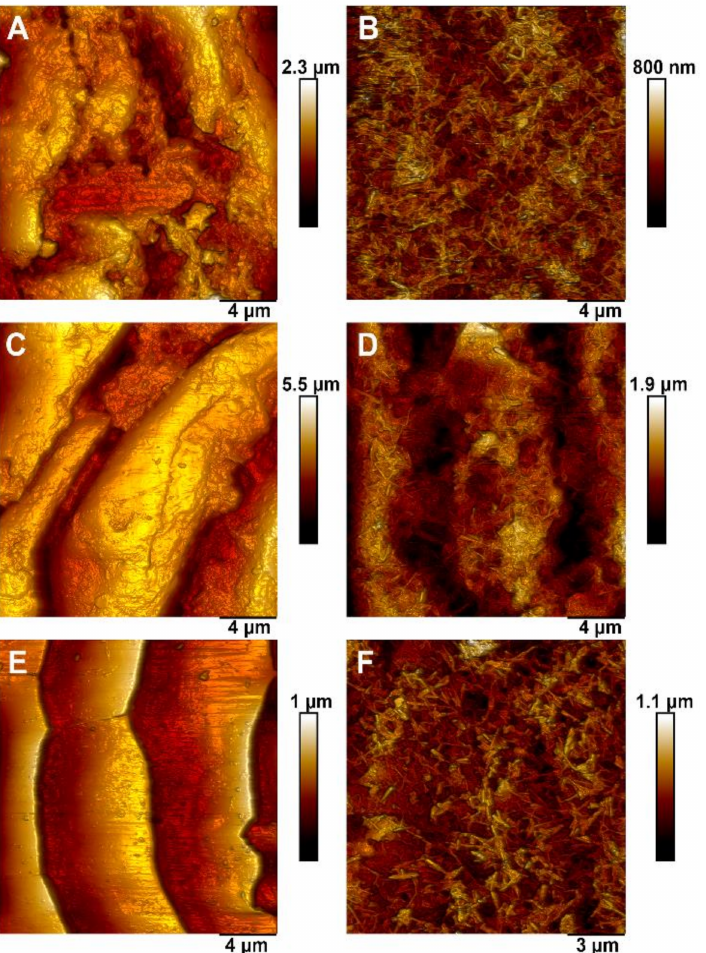
Figure 4. AFM topography images of capybara ( A – D ) and guinea pig ( E , F ) hair before and after coating with halloysite. Interestingly, on the nanoscale, the wax-free capybara hair demonstrated the increased cuticle roughness of both Ra (arithmetical mean roughness) and Rq (root mean squared roughness) which occurs apparently due to the removal of the smoothing wax